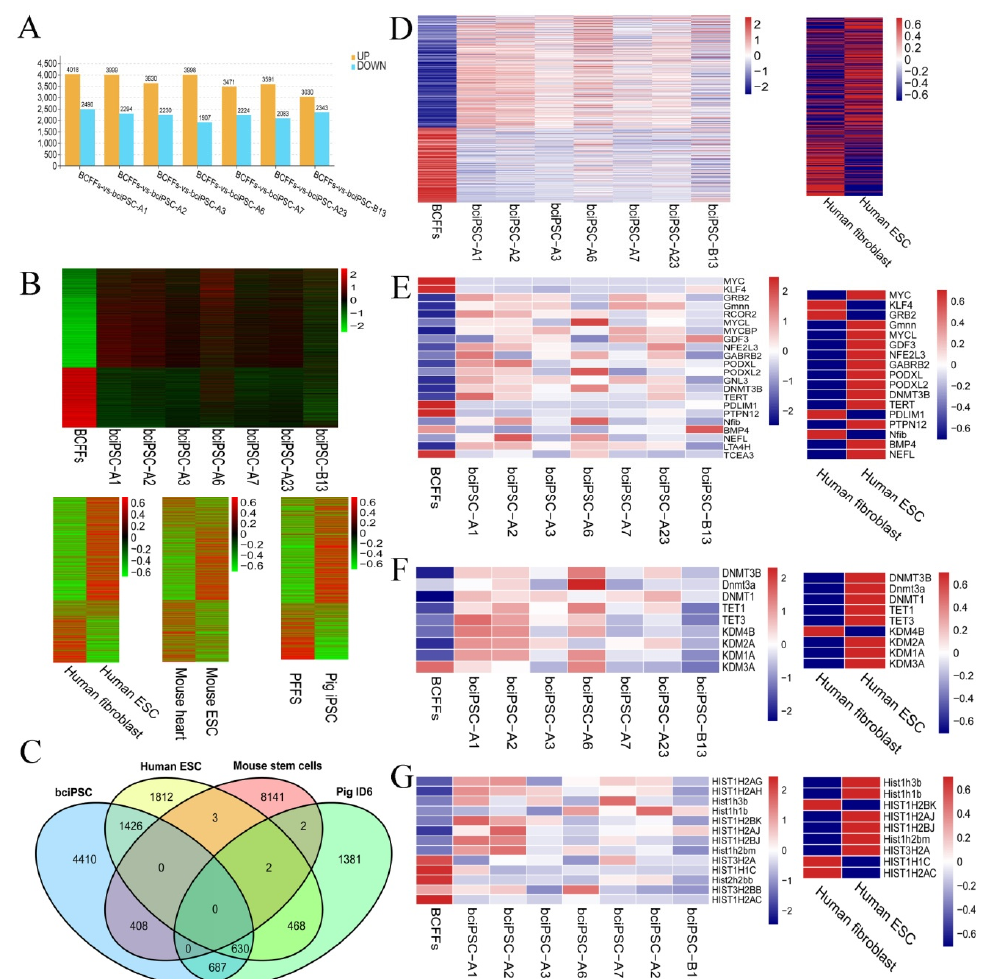
Figure 4. RNA-Seq verifies the pluripotency of bciPSCs. ( A ) differential gene histogram, ( B ) non- clustering heat maps of significantly up-regulated and down-regulated genes in bciPSC lines, and non-clustering heat map of significantly different genes in Bactrian camel sequencing data mapped to mouse ESC cell, human ESC cell, and pig iPSC microarray data, ( C ) venn diagrams of the significantly different genes in the four species of ESC and iPSC. The screening conditions for significantly different genes were |log 2 FC| ≥ 1, FDR < 0.05, ( D ) heatmaps made of genes in all signaling pathways of interest in bciPSCs, and the results of the mapping of corresponding genes into human ESC, ( E ) heatmaps of pluripotency genes and pluripotency-related gene expression in Bactrian camel samples, and heatmaps when each gene was mapped to human ESC, ( F ) heatmap of DNA methyltransferases, DNA methyl oxidases, and histone demethylases in bciPSC and human ESC, ( G ) heatmap of all histone genes in bciPSC sequencing data, and the results mapped into human